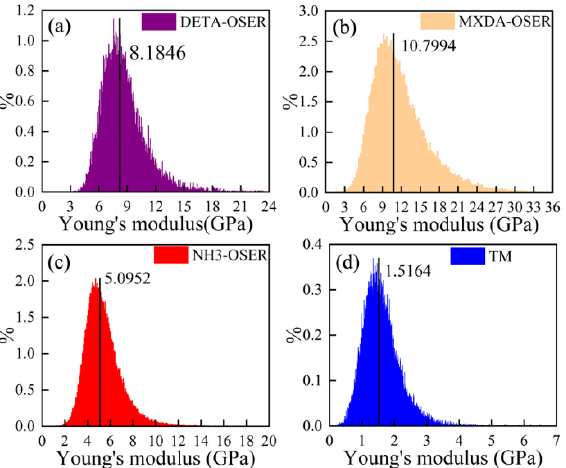
Figure 4. Histograms of the Young’s modulus distribution of the coatings. ( a ) DETA-OSER. ( b ) MXDA-OSER. ( c ) NH 3 -OSER. ( d ) TM.